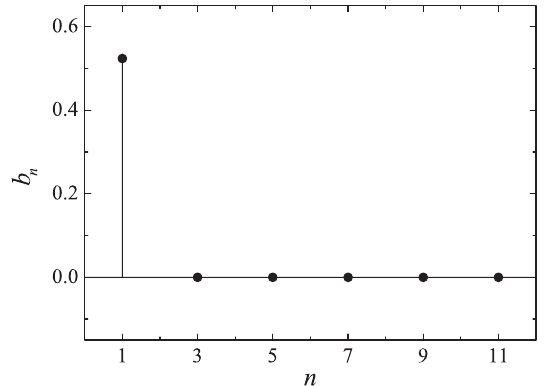
FIG. 5. The normal multipole coefficient b n of an elliptic beam tube with geometry shown in Fig. 4. The sextupole component is zero after changing the thickness with (cid:6) ð (cid:4) Þ ¼ l ð (cid:4) Þ .